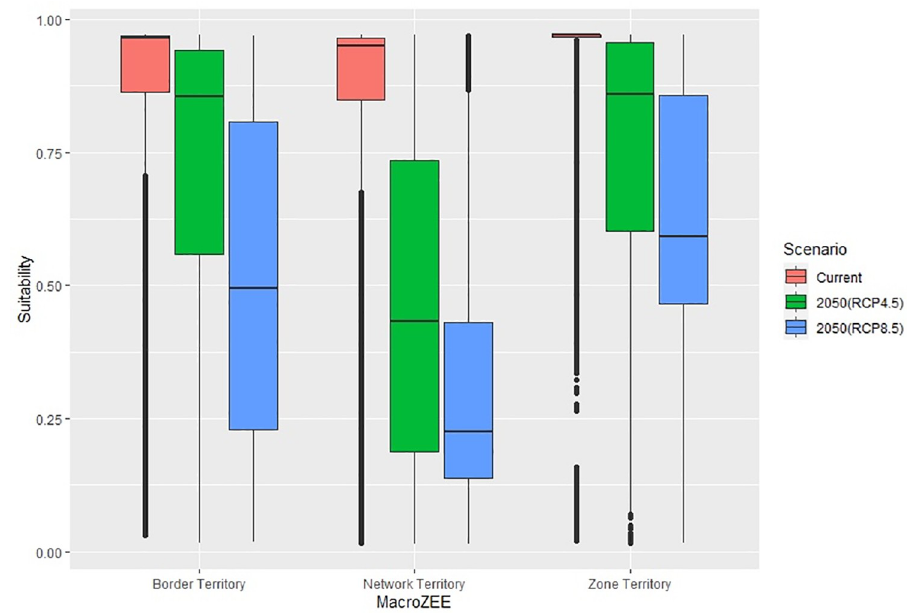
Fig 3. Distribution of current and future cocoa adequacy (RCP 4.5 and 8.5 scenarios) in MacroZEE territories.